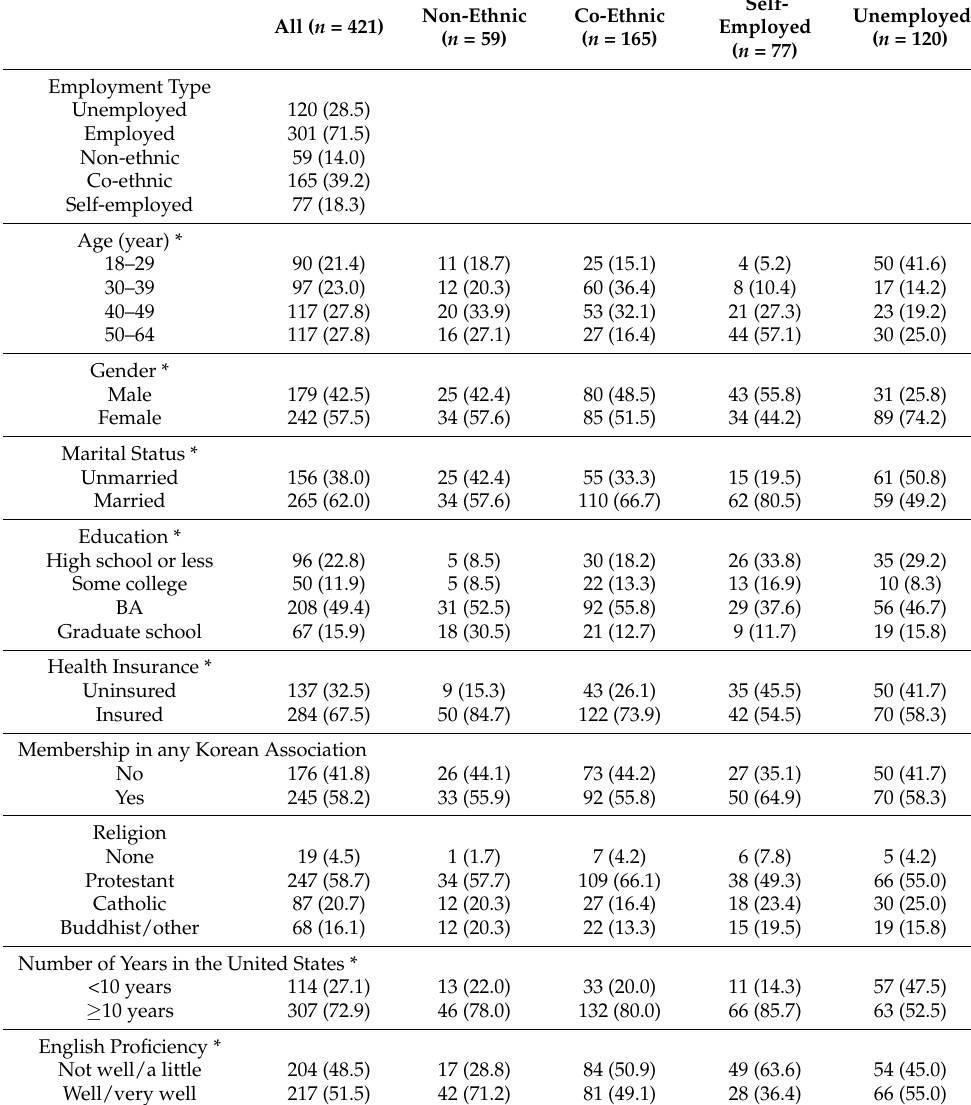
Table 1. Characteristics of Survey Participants by Employment Type, n